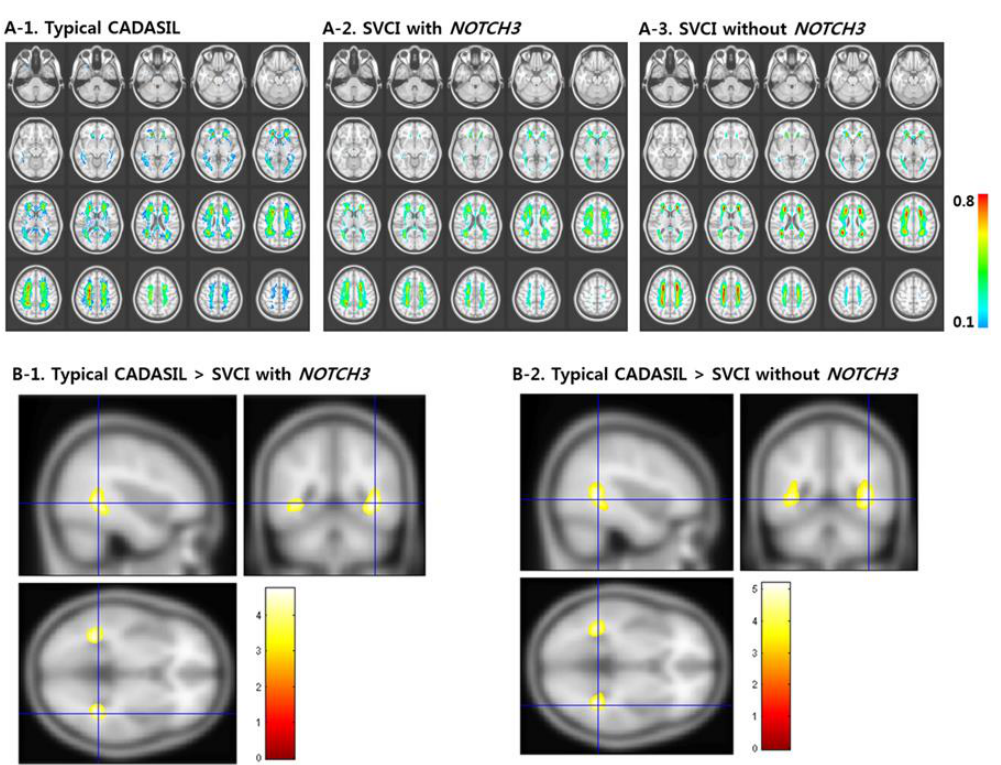
Figure 2. Multimodal imaging analyses in CADASIL and SVCI patients with and without NOTCH3 variants. WMH frequency maps of forms of CADASIL ( A ) and comparison of frequency maps between the typical CADASIL and SVCI groups ( B ). ( A - 1 ) Typical CADASIL patients show extensive WMH distributed throughout the periventricle, posterior temporal white matter, and anterior temporal white matter. ( A - 2 ) SVCI patients with NOTCH3 variant and ( A - 3 ) SVCI patients without NOTCH3 variants showed similar WMH frequency maps. ( B - 1, B - 2 ) Typical CADASIL cases reveal significantly prevalent WMH distribution in the bilateral posterior temporal region compared with SVCI patients with and without NOTCH3 variants. Reprinted with permission from ref [40]. Copyright under a CC BY